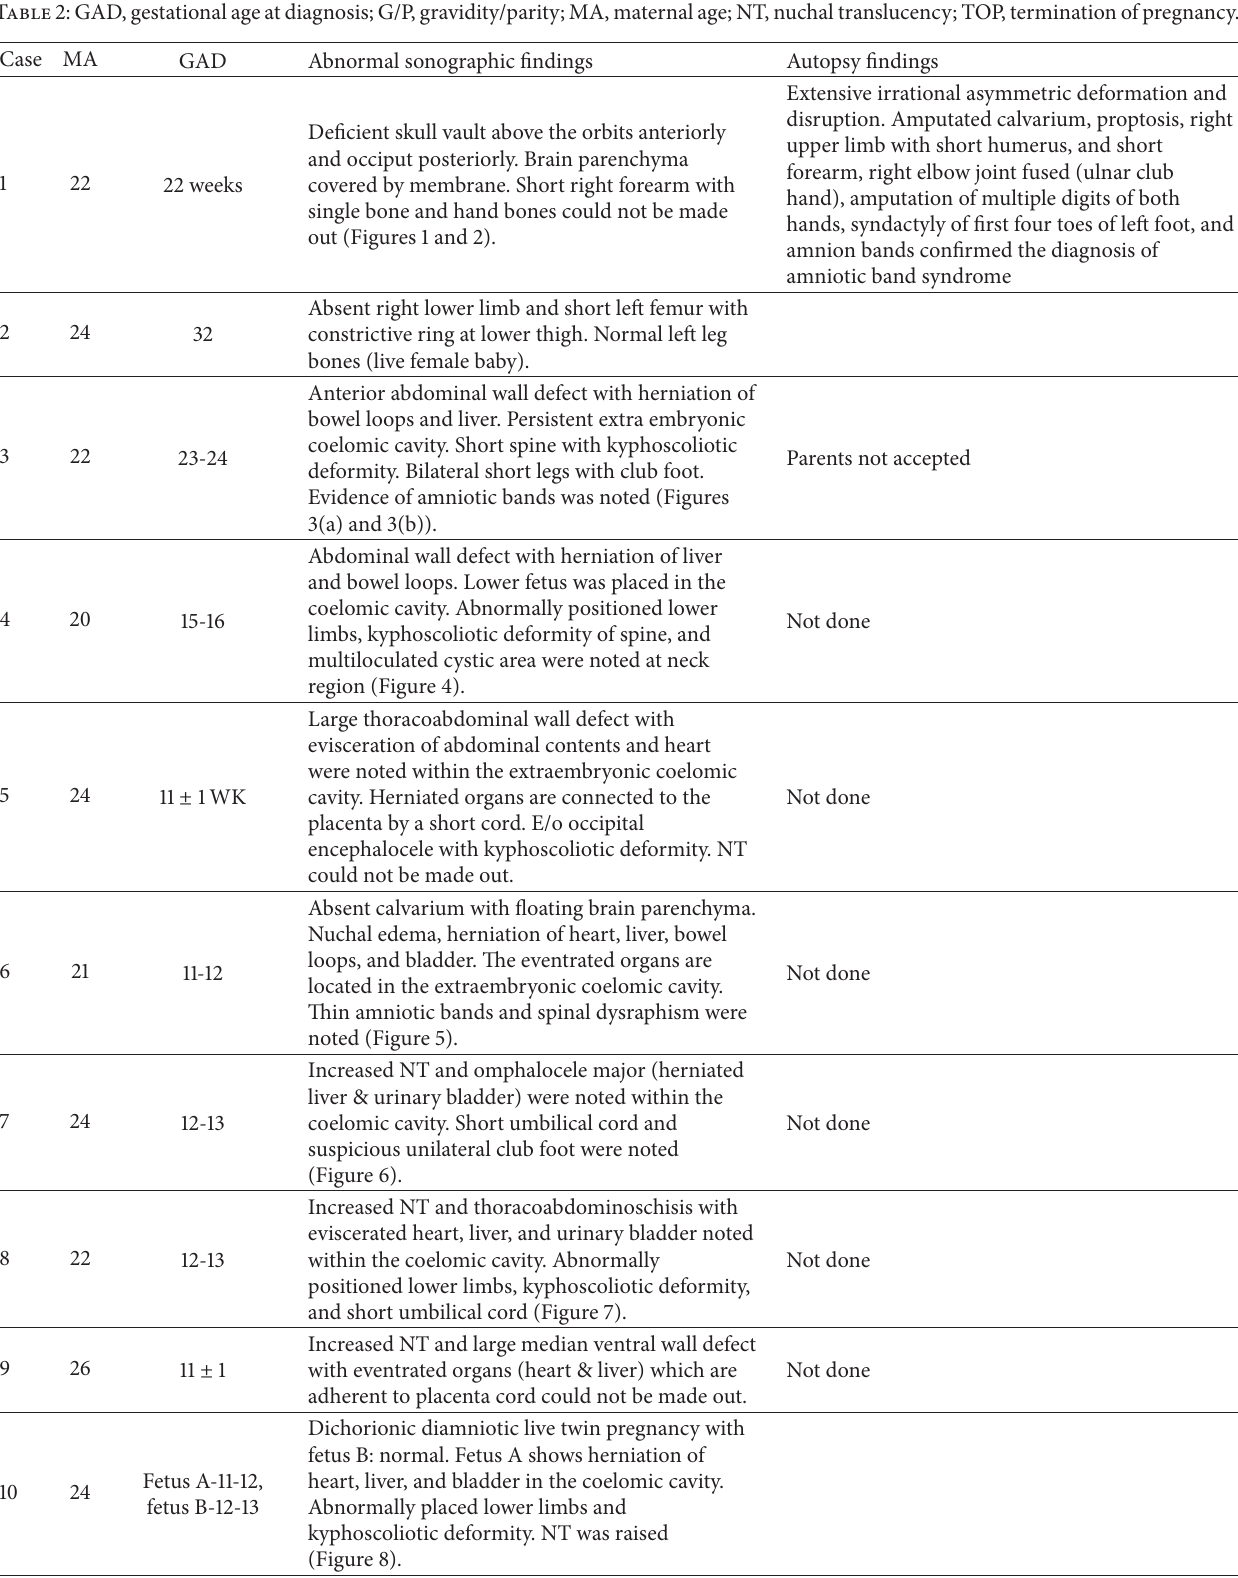
Table 2: GAD, gestational age at diagnosis; G/P, gravidity/parity; MA, maternal age; NT, nuchal translucency; TOP, termination of